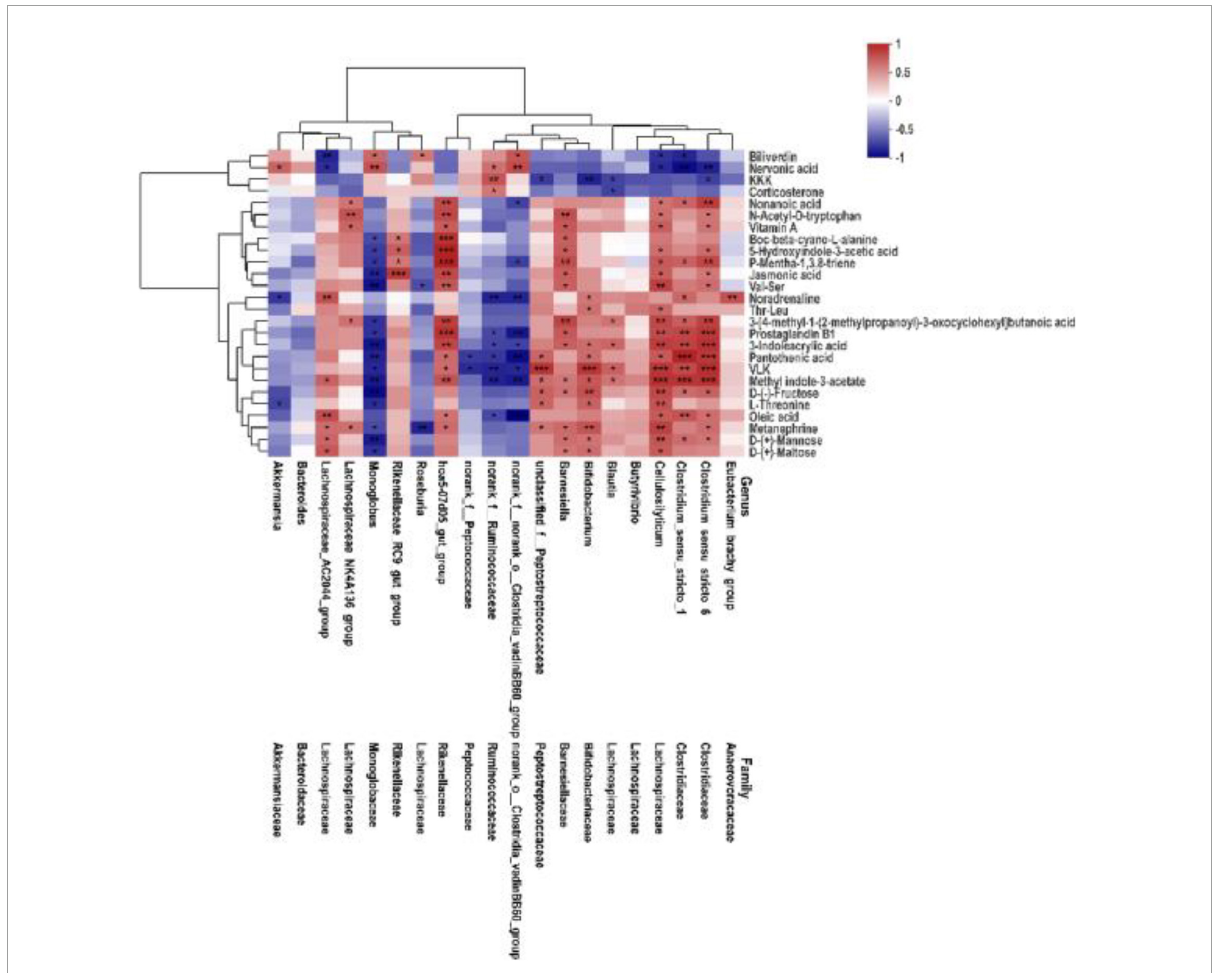
FIGURE7 Association heatmap of Spearman’s correlations analyses integrating key microbes and metabolome of fecal. The color scale represents the Spearman’s R-value (red, positive correlation; blue, negative correlation). * p < 0.05, ** p < 0.01, and *** p <